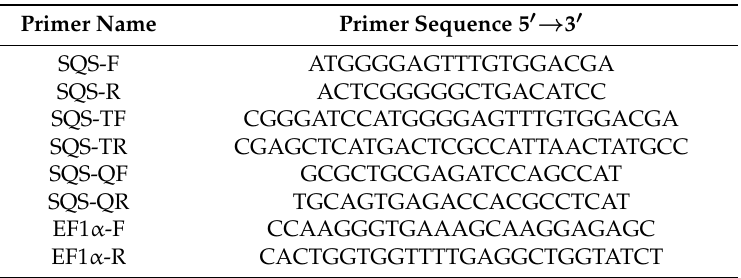
Table 1. Primers used in this